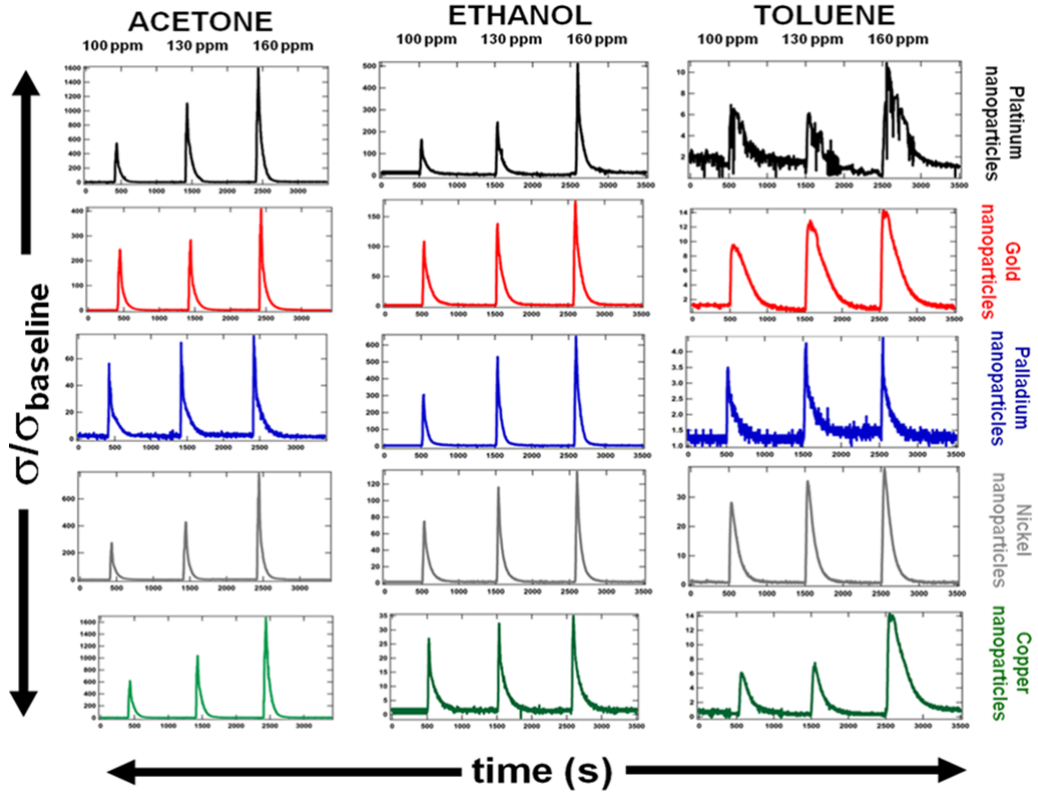
Figure 4. Integrated matrix of responses to tree types of chemical vapors. Each column